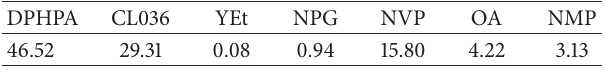
Table 1: Composition for LC-photopolymer composite in wt%.